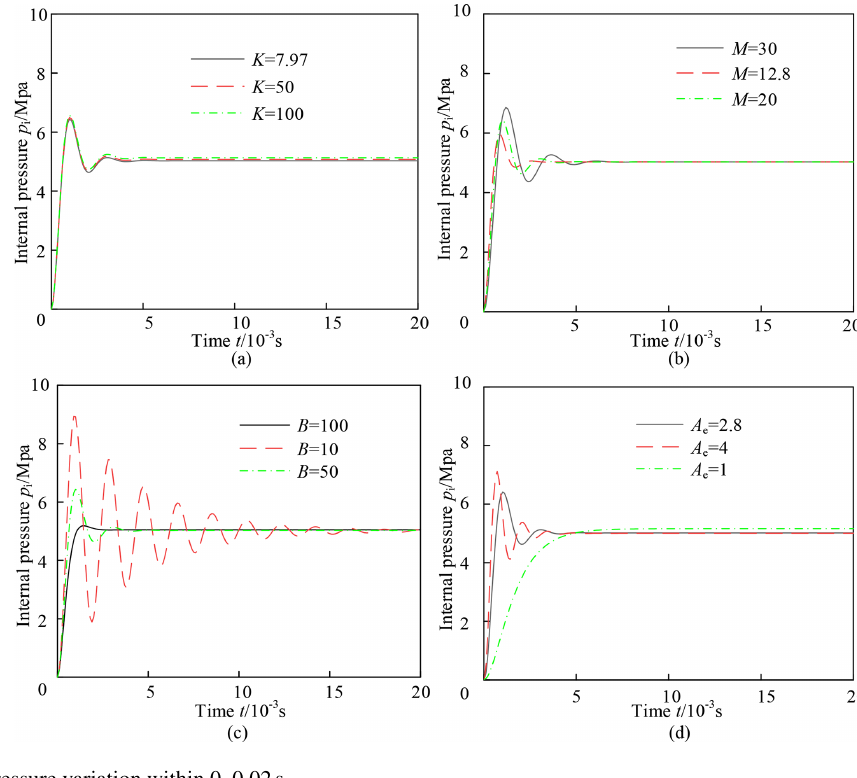
Figure 9. Internal pressure variation within 0–0.02s.